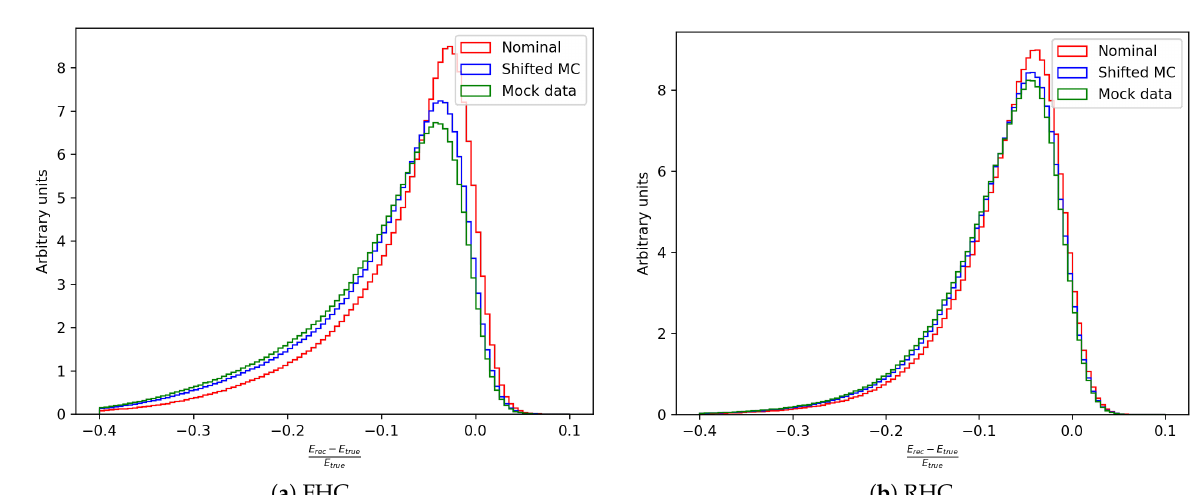
Figure 95. Fractional difference between true and reconstructed neutrino energy for the nominal sample (red) and mock data sample before (blue) and after (green)